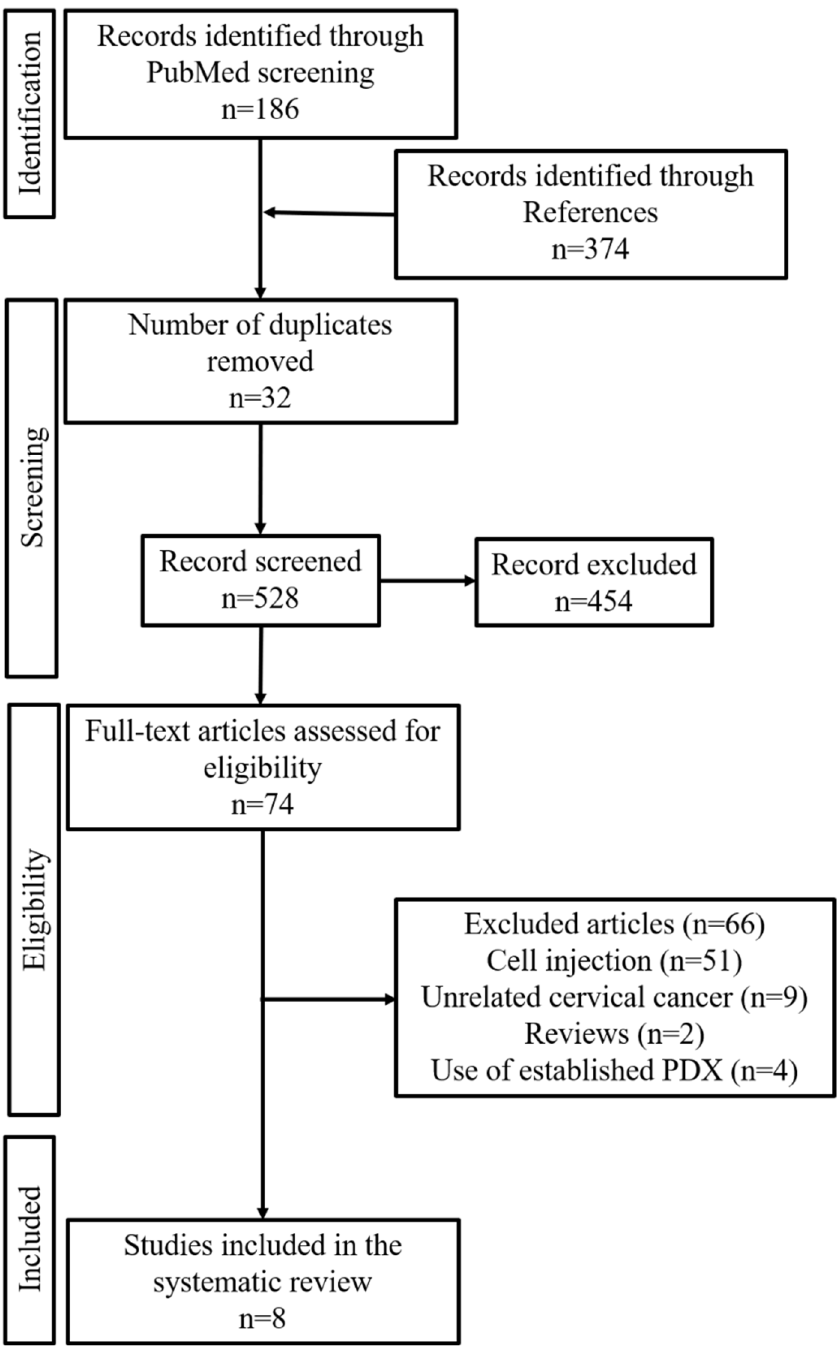
Figure 2. Flowchart showing the results of the search process.